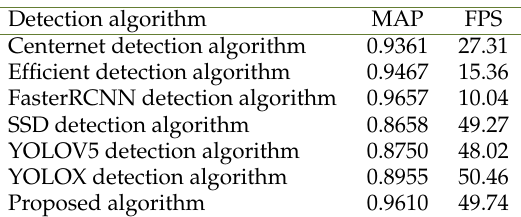
Table 4. Performance comparison of various defect detection algorithms.